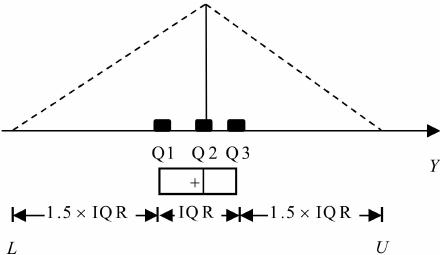
Figure 3. The reasonable ranges can be defined by the box-and-whisker